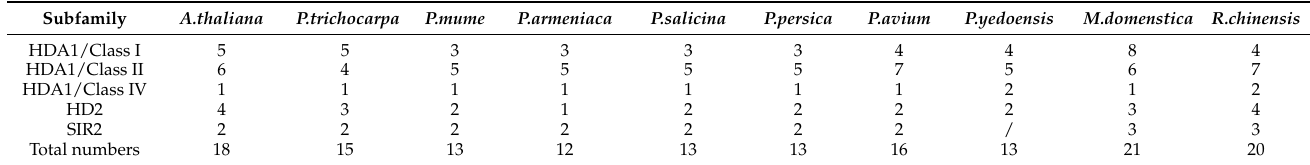
(Table S4). The characteristic of all putative HDACs sequences, predicted conserved domains and other structures of the proteins were listed in Table S3. Table 1. HDACs genes identified in HDACs family of 10